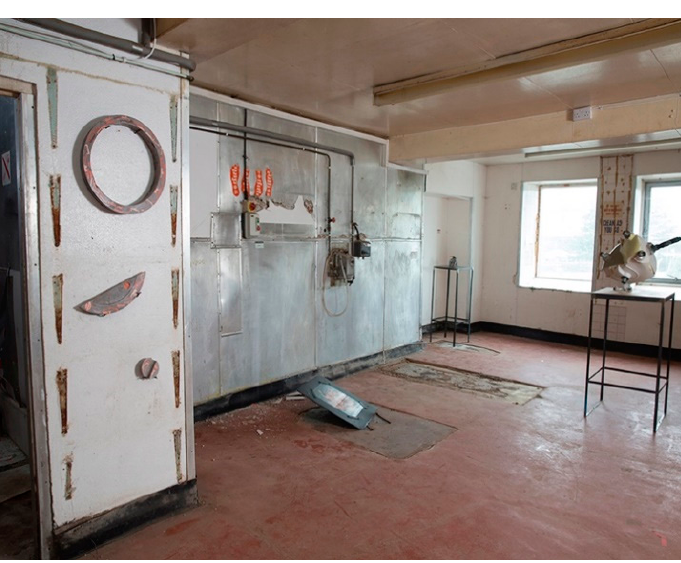
Figure 2. S-O-T Body Repairs solo exhibition at the Old Bakery.